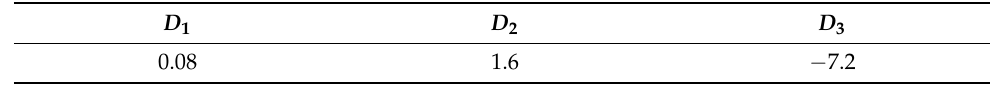
Table 4. Failure constants of